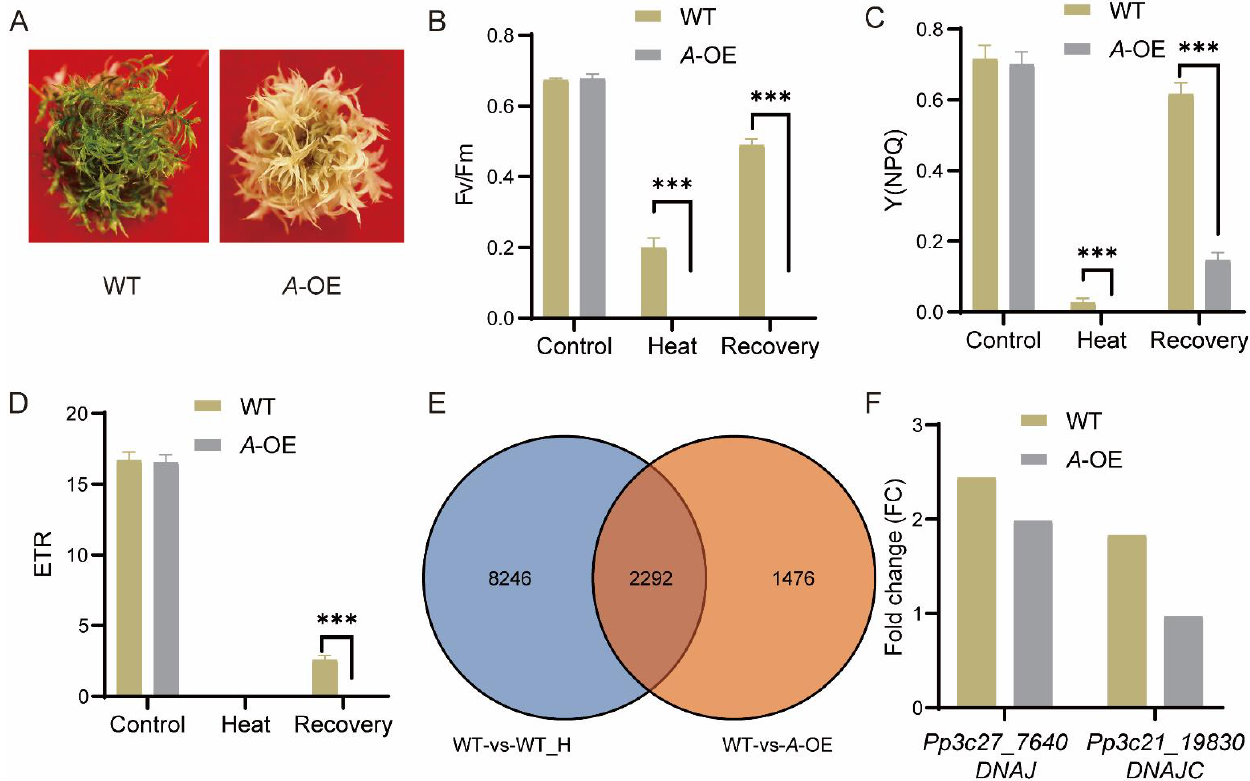
Figure 5. Response of A -OE plants to heat stress (HS) treatment. ( A ) A -OE plants were more sensitive to heat stress. ( B – D ) Chlorophyll fluorescence (Fv/Fm) ( B ), non-photochemical energy dissipation (NPQ) ( C ), and electron transport rate (ETR) ( D ) of WT and A -OE before HS, after HS, and after recovery from the heat stress. Data are presented as means ± SEM of three replicates; t -test was used for statistics; asterisks indicate the significant difference between WT and A -OE, *** p < 0.001. ( E ) Venn diagram shows the overlapping between HS-regulated DEGs in WT (WT versus WT under heat stress) and PpRNH1A -regulated DEGs (WT versus A -OE under normal growth conditions). ( F ) Fold change comparison of the expression levels of DNAJ and DNAJC under HS and normal condi- tions. Each bar represents the ratio of the average expression value of three biological replicates of HS (after heat stress) vs . control (before heat stress). 2.6. PpRNH1A Regulates the Expression of Heat-Responsive Genes including DNAJ and DNAJC Considering that overexpression plants are more sensitive to heat stress, we then tested if PpRNH1A regulates the heat-related genes. Transcriptomic profiles of WT plant s before HS (control) and 18 h after HS were compared to identify the heat-responsive genes. In total, 10,538 DEGs (Fold change > 1.5 or 0 < Fold change < 0.67, p -value < 0.05) were found responding to heat stress in wild-type plants (collection: WT-vs-WT_H). To identify the genes regulated by PpRNH1A , 3768 DEGs were identified from the compari- son between WT and A -OE plants under normal growth conditions (collection: WT-vs- A - OE). The overlap of these two collections of DEGs showed that 2292 heat-related genes were regulated by PpRNH1A (Figure 5E). Representative heat-related genes [47] such as Pp3c27_7640 (molecular chaperone DNAJ , HSP40 ) and Pp3c21_19830 (DNAJ homolog subfamily C member DNAJC ) were selected for further analysis. Heat stress significantly induced the expression level of DNAJ and DNAJC in WT plants. However, in A -OE plants, DNAJC was not induced by heat (Figure 5F). The fold change of DNAJ induced by HS in A -OE plants was much less than that in the WT plants. These results suggest that PpRNH1A regulates the expression of heat-responsive genes, including DNAJ and DNAJC (Figure 5F).